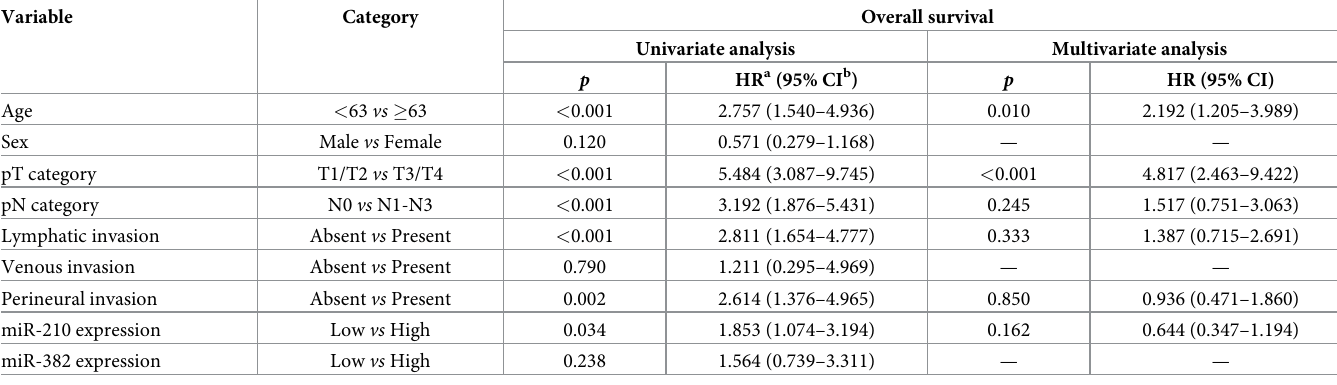
Table 2. Univariate and multivariate survival analysis for overall survival in gastric adenocarcinoma. Variable Category Overall survival Univariate